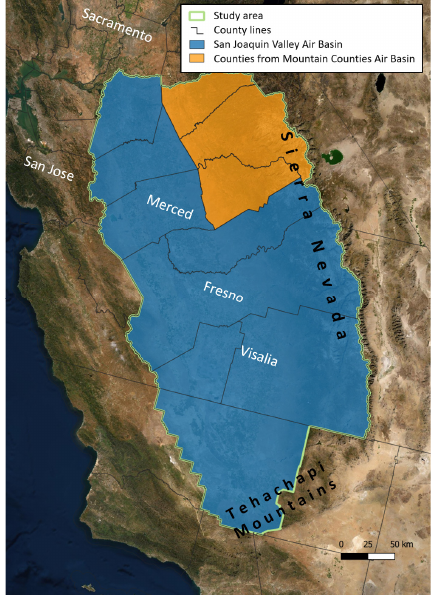
Figure 1. Counties and air basins covered in this